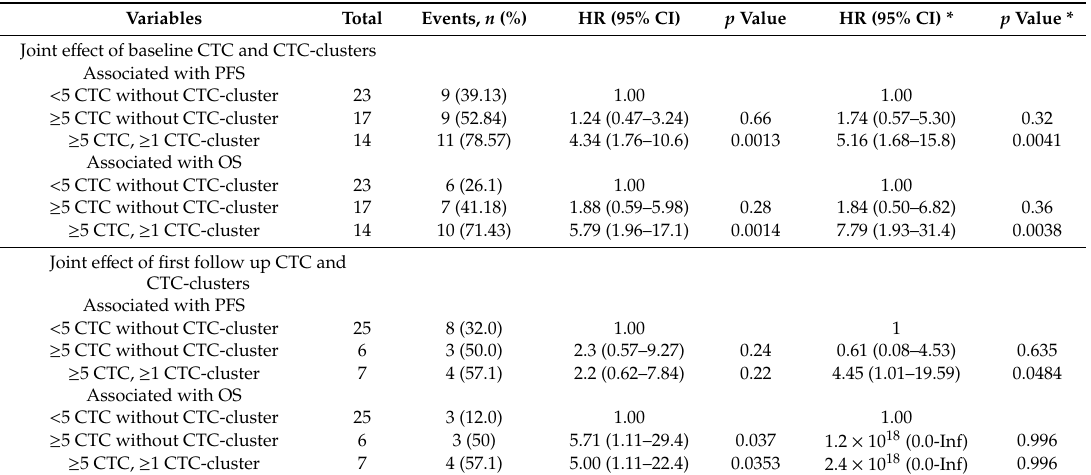
Table 3. Joint e ff ect analysis of CTCs and CTC-clusters with patient PFS and OS.